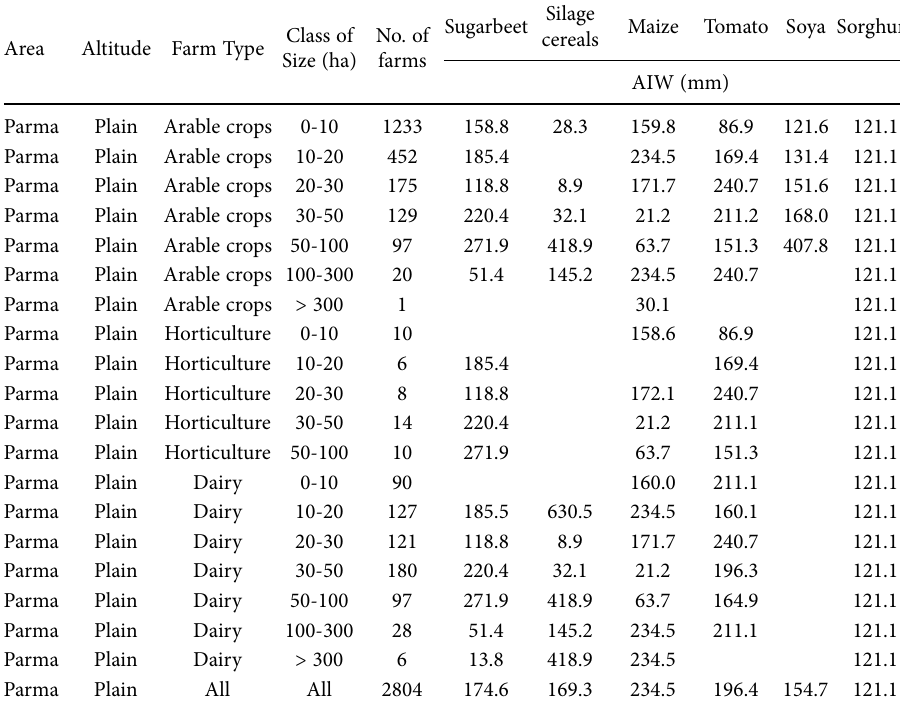
Table 5. Estimated AIW per crop in Parma